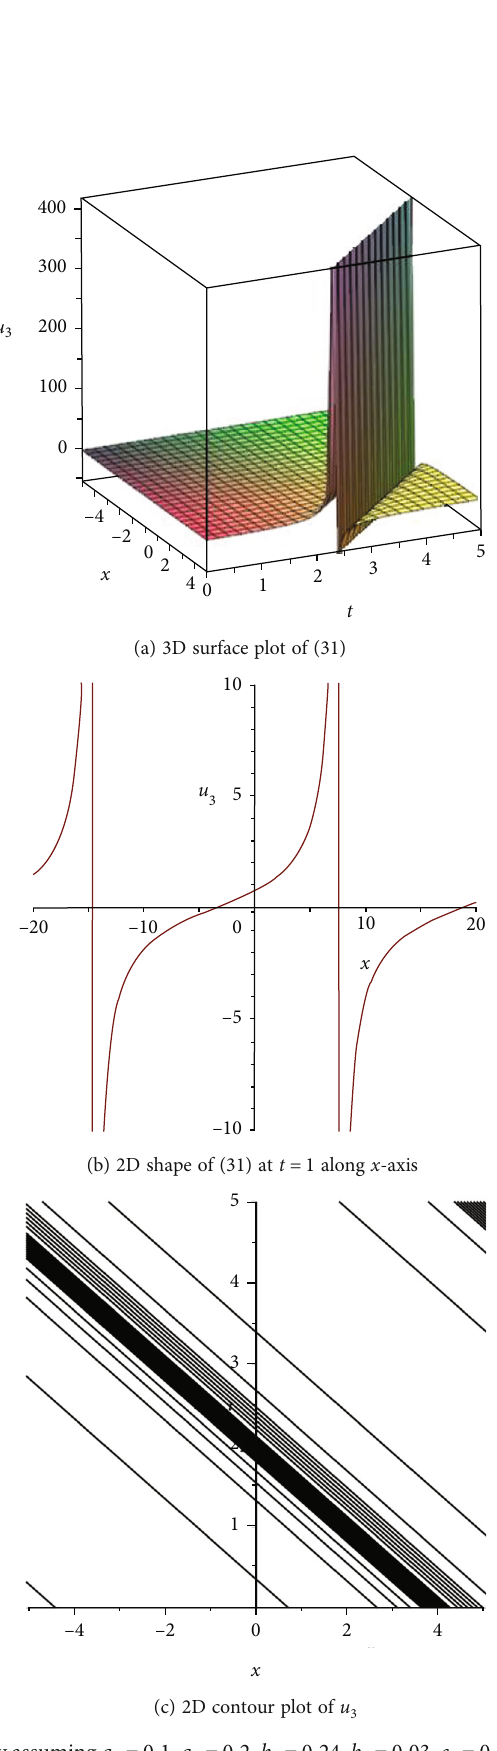
3 by assuming = 0 : 002 , β = − 0 : 768 , σ 1 2